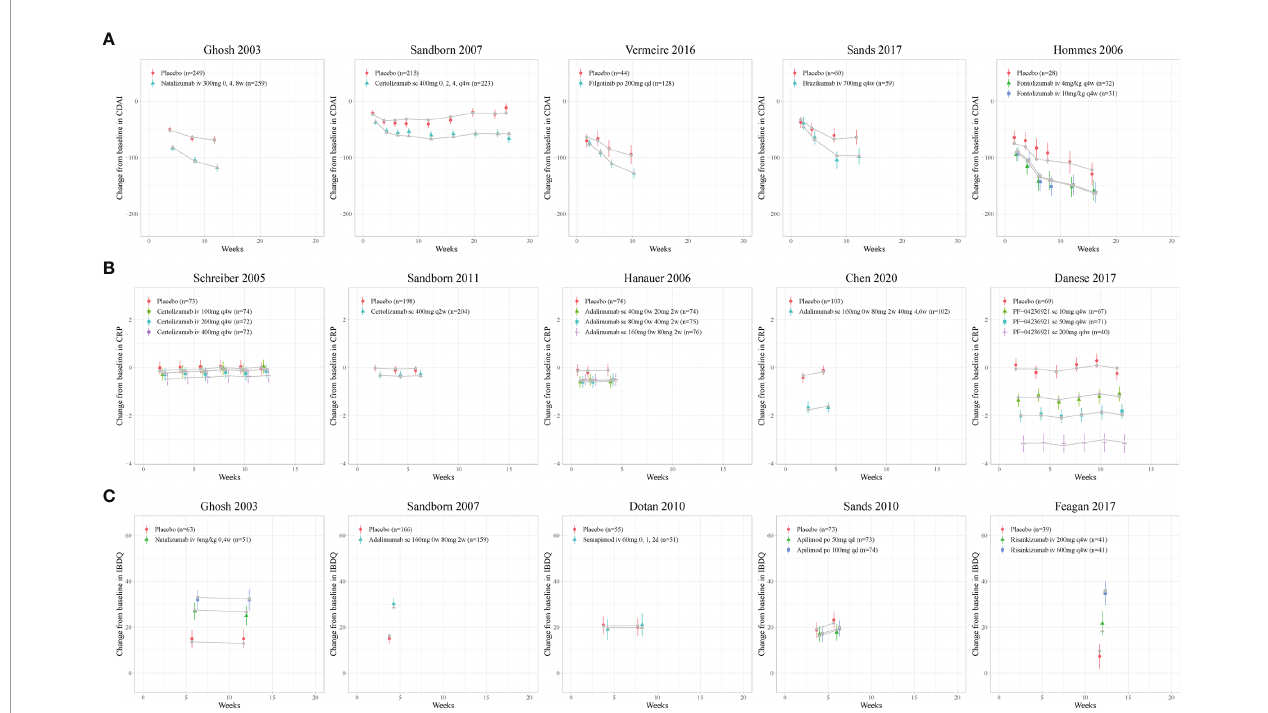
FIGURE 3 | Model fi tted time-course plots of (A) CDAI, (B) CRP, and (C) IBDQ change from baseline for representative trials. Color symbols and vertical bars are observed mean and calculated weight of time points; gray symbols and lines are the model predictions. CDAI, Crohn ’ s Disease Activity Index; CRP, C-reactive protein; IBDQ, In fl ammatory Bowel Disease Questionnaire; qd, once every day; q2w, once every 2 weeks; q4w, once every 4